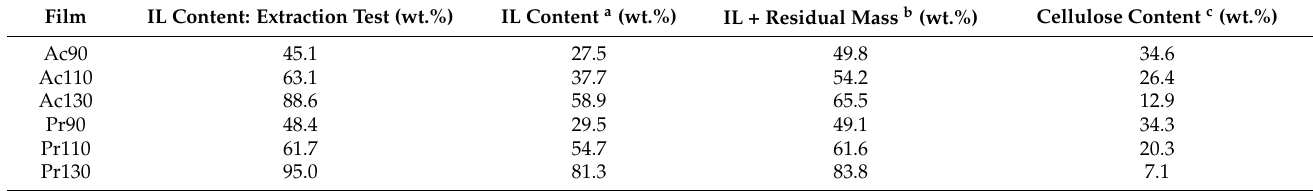
Table 4. Cellulose and IL contents calculation by TGA.